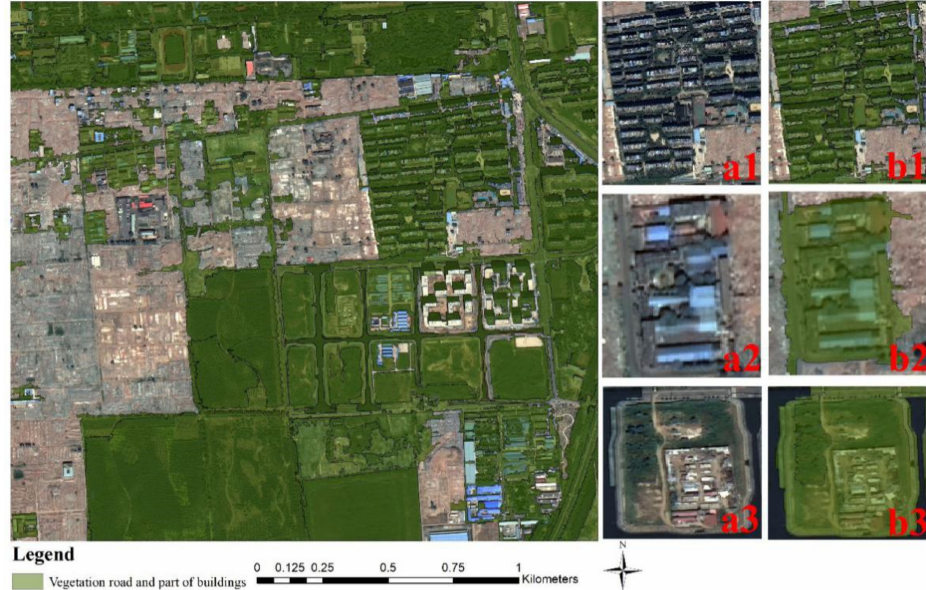
Figure 24. The result diagram of the first layer classification structure: ( a1 – a3 ) the corresponding original images. ( b1 ) the corresponding original images. ( b2 ) the buildings in the demolition area. ( b3 ) a small car park surrounded by